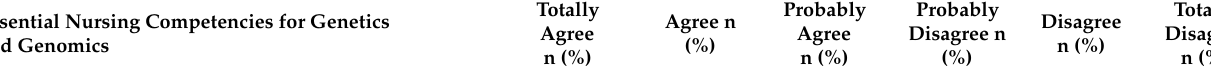
Table 6. Perceptions of the instructor responsible for the genetics content with regard to “Essential Nursing Competencies and Curricula Guidelines for Genetics and